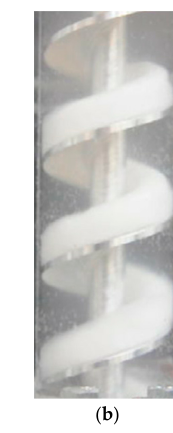
Figure 6. Different working conditions of LHTES unit with spiral fins [61]. ( a ) Shell exposed to air; ( b ) Shell slightly heated. (Permission to reproduce from Ref.